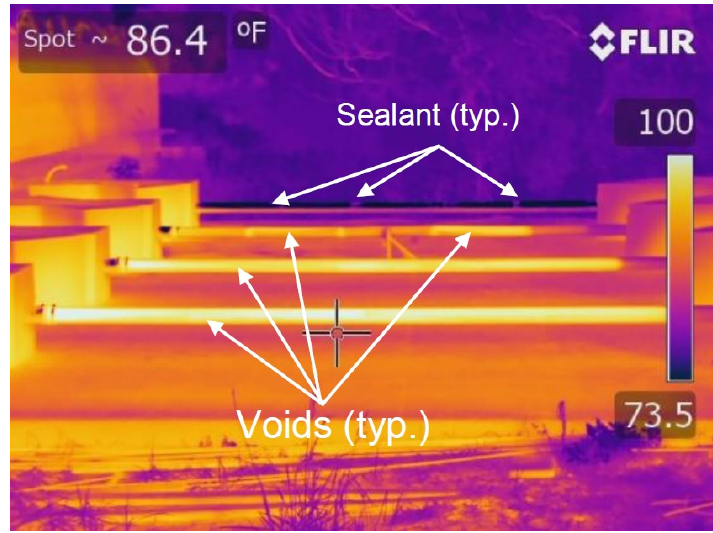
Figure 5. Photo captured by infrared thermography with interpretation [9].